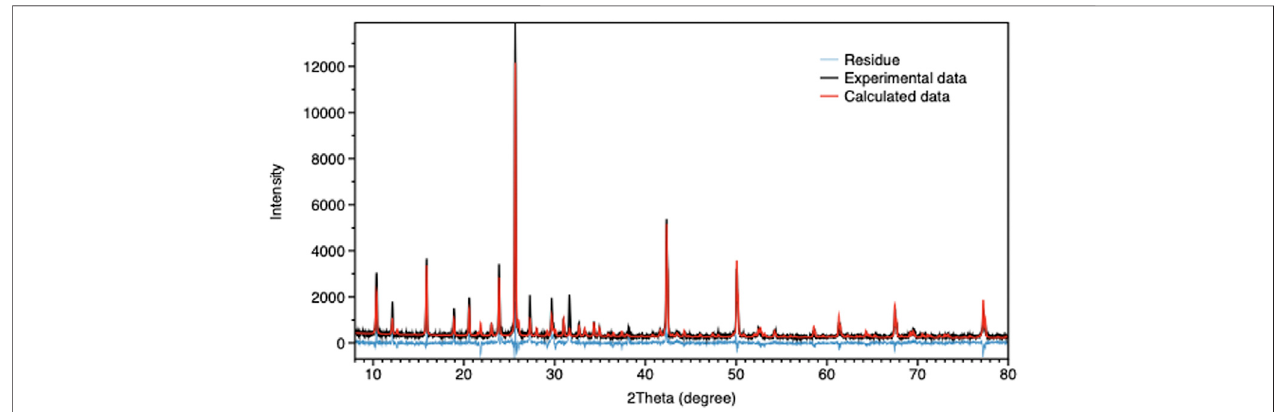
FIGURE 3 | TOPAS calculation result for CuI@ZeoL. The black curve shows the measured XRD data, the red curve shows the calculated Rietveld fi tting, and the blue curve shows the difference between the former and the latter.